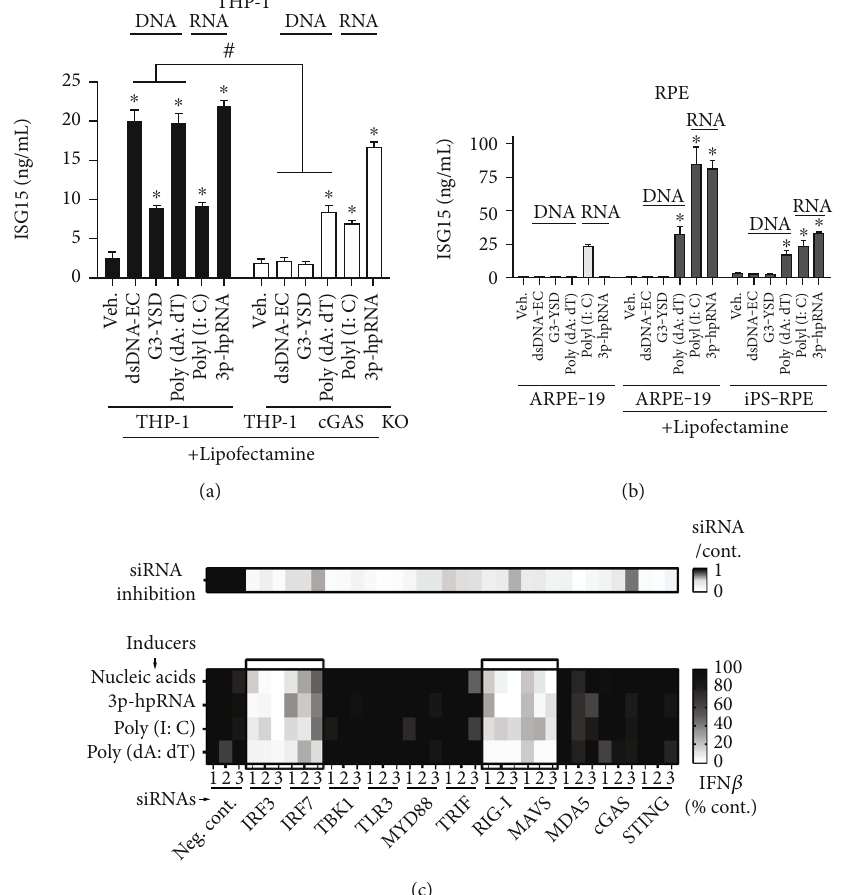
Figure 2: Identi fi cation of RIG-I as the key sensor in type I IFN response in RPE. (a, b) RNA but not DNA could be sensed by RPE to induce type I IFN response, suggesting the lack of DNA sensors in unstimulated RPE. THP-1 and THP-1 cGAS KO cells were used as controls (a). Cells were treated with indicated inducers at 0.25 μ g/mL, with or without the Lipofectamine transfection reagent, and intracellular ISG15 was measured by ELISA 24h after stimulation. Each bar represents biological replicates ( n = 3 ) and is indicated as mean ± SD . Note that ARPE-19 without transfection did not respond to most tested inducers except for poly(I:C). ∗ p < 0 : 05 compared with corresponded vehicle-treated groups. # p < 0 : 05 compared with same induces in parental cells. (c) Type I IFN response was induced via the RIG-I – MAVS – IRF3 axis in ARPE-19 cells. ARPE-19 cells were cultured 10 d after reaching con fl uence for screening purposes. Di ff erent key nodes for the activation of the IFN pathway were knocked down using siRNAs (at least 3 di ff erent siRNAs for each gene). Cells were then treated with indicated nucleic acids, and the release of secreted IFN- β was measured by ELISA 24 h after stimulation. Similar results were observed in 3 independent experiments with di ff erent inducers (indicated in di ff erent lines) or di ff erent siRNAs (shown as di ff erent column); a single representative experiment is shown as an example. A heatmap was used to better visualize the percentage (%) change in the results. The e ffi ciency of the mRNA knockdown was validated by qPCR and shown at the top in the form of heatmap. About ~ 70% inhibition was observed in most tested